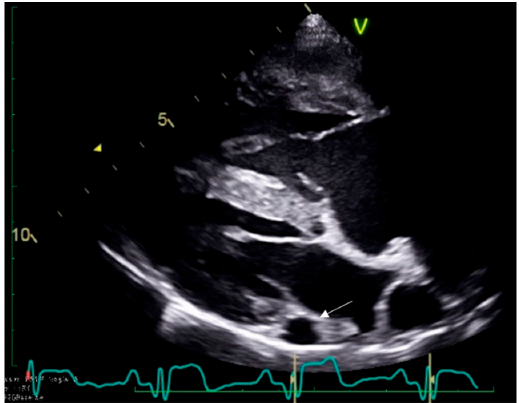
Figure 2. Echocardiographic right parasternal long axis view showing right ventricular hypertrophy and dilation, right atrial enlargement, and dilation of the coronary sinus (white arrow) in Case 2. The CTA, performed using a GE Optima 660 (64 slices), revealed persistent left cranial vena cava and no coronary artery anomalies; it also confirmed the absence of the right EJV. Given the absence of the right EJV and the persistence of the left cranial vena cava, the PBV was successfully performed by vascular access through the right femoral vein without complications (Figure 3).